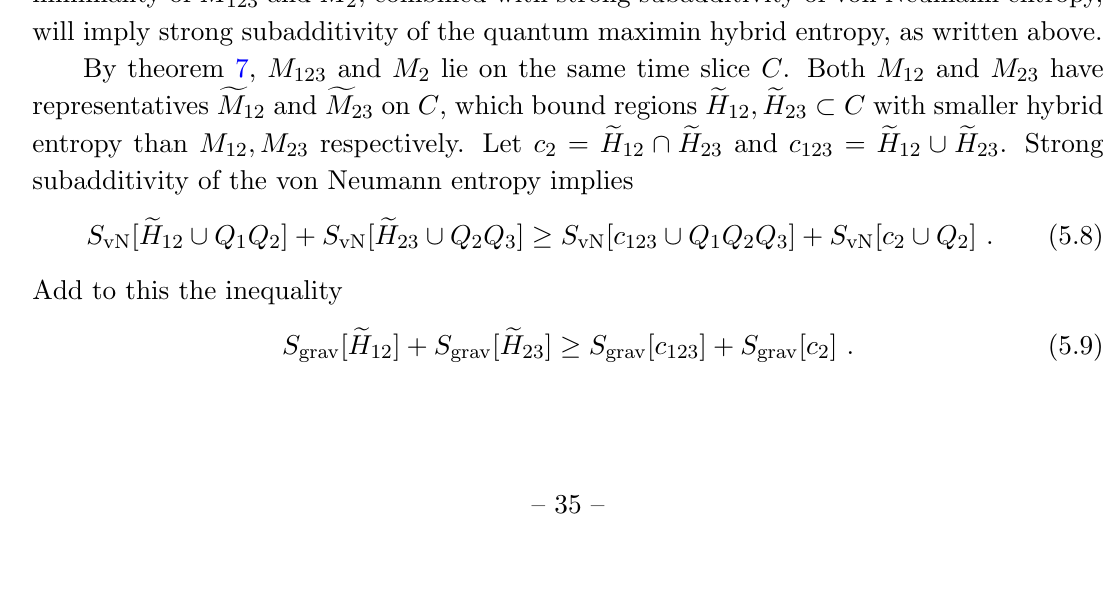
Figure 9 . The Hybrid entropy quantum maximin surfaces satisfy an appropriate extension of entanglement wedge nesting. It is shown by contradiction that we must have H R when R 1 (cid:18) D [ R 2 ], and Q 1 (cid:26) Q 2 thus proving entanglement wedge nesting for the hybrid entropy.